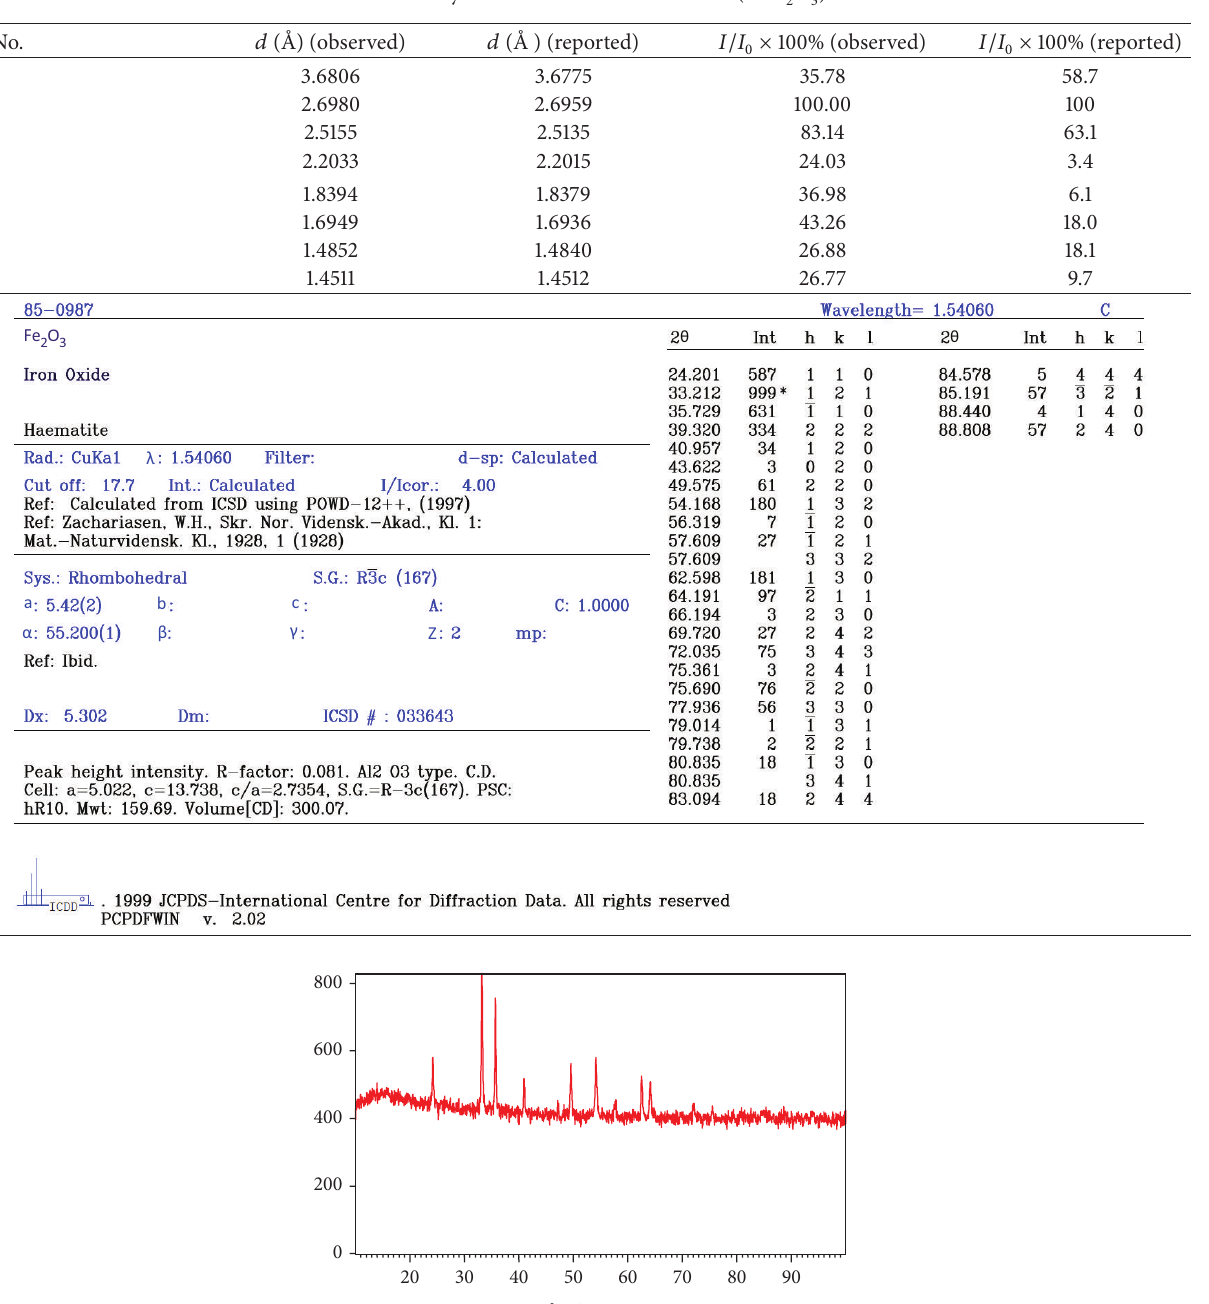
Table 1: X-ray diffraction data for iron oxide ( 𝛼 -Fe